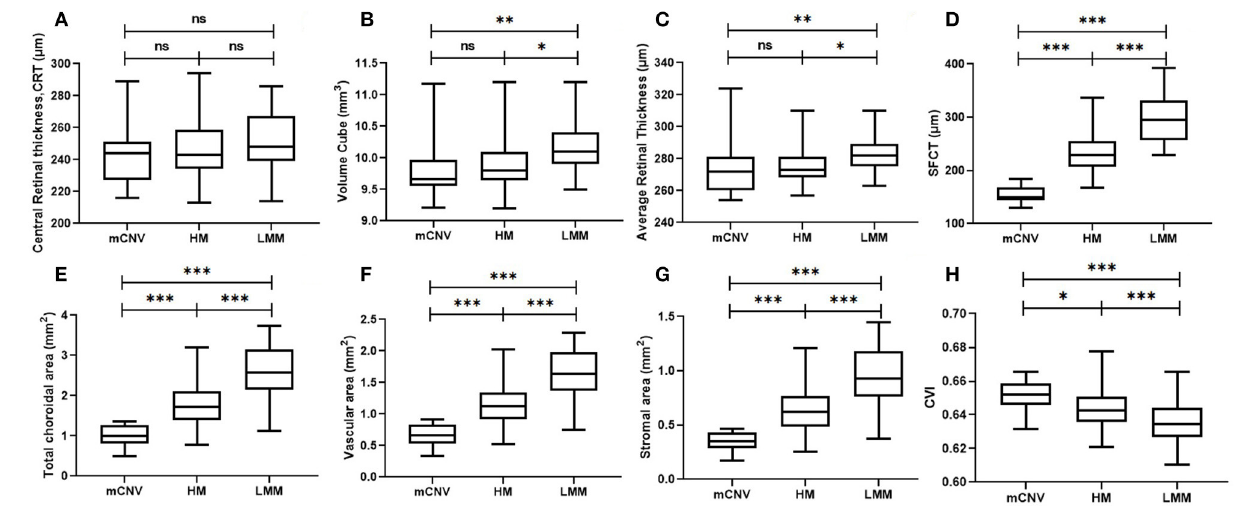
FIGURE 2 | Retinal and choroidal morphological and vascular characteristics on OCT, including central retinal thickness (A) , retinal volume cube (B) , average retinal thickness (C), subfoveal choroidal thickness (D) , total choroidal area (E) , choroidal vascular area (F) , choroidal stromal area (G) , and CVI (H) in LMM ( n = 78), HM ( n = 53), and mCNV ( n = 17) eyes. LMM, low-to-moderate myopia; HM, high myopia; mCNV, myopic choroidal neovascularization; OCT, optical coherence tomography; SFCT, subfoveal choroidal thickness; CVI, choroidal vascular index. ns, no significance; * p < 0.05; ** p < 0.01; *** p < 0.001. p -value was calculated using independent t -test.